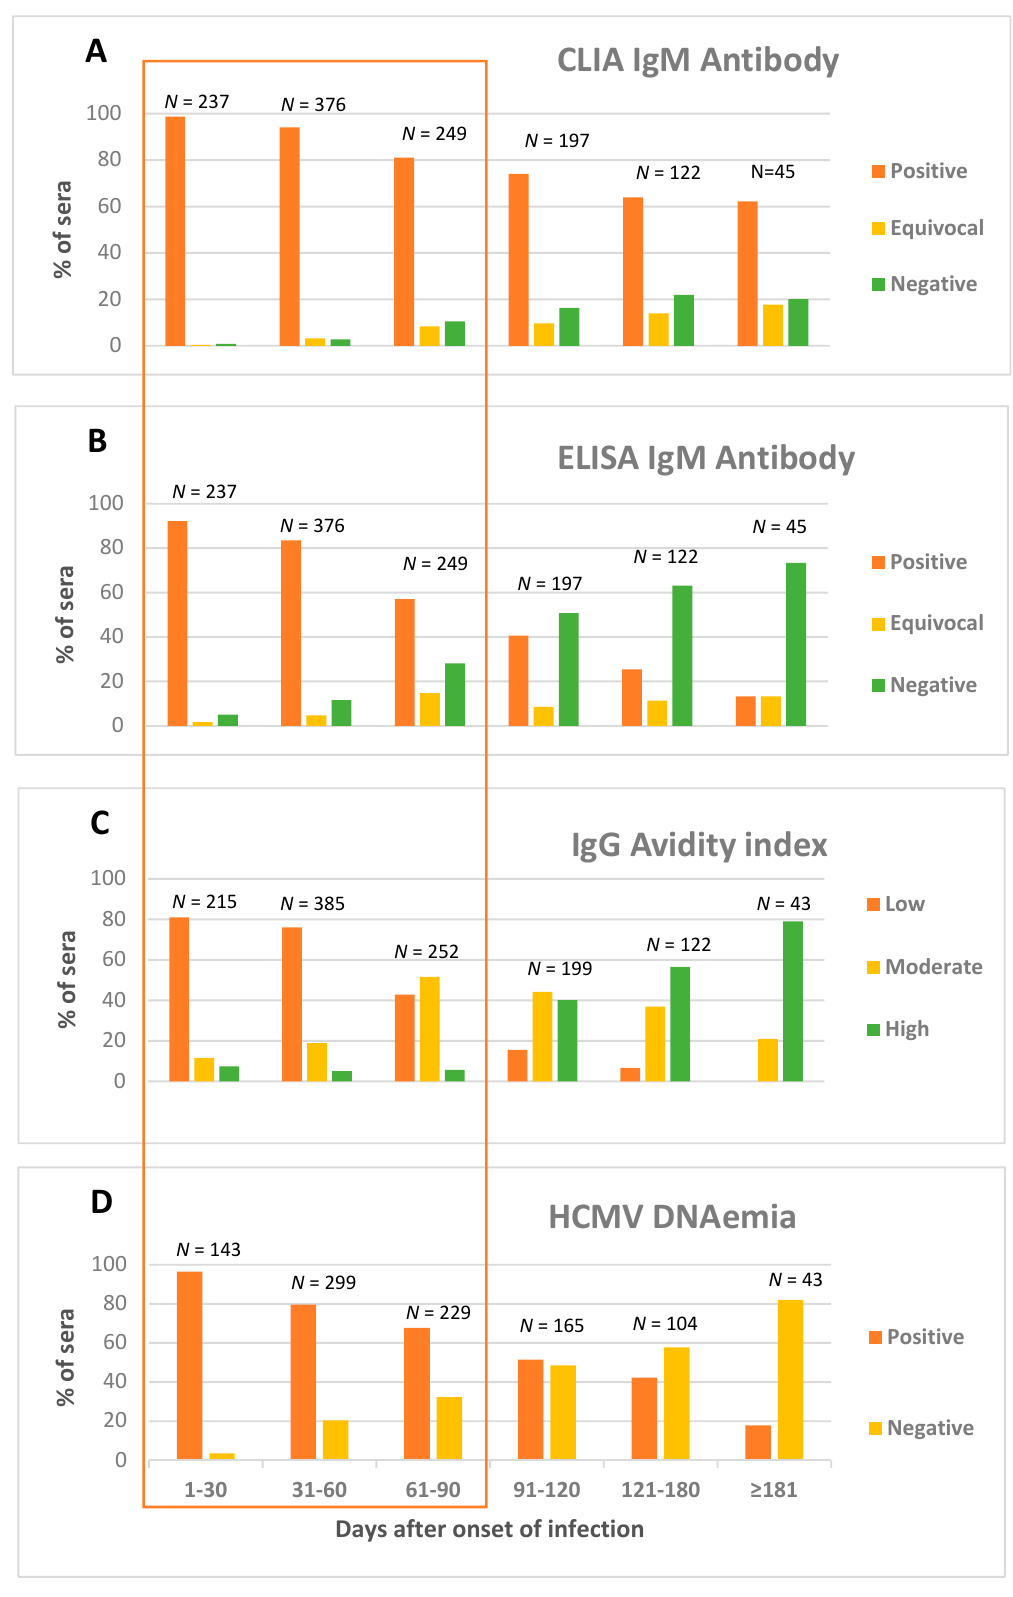
Figure 1. Human cytomegalovirus (HCMV) chemiluminescent immunoassay (CLIA) IgM ( A ) and enzyme-linked im- munosorbent assay (ELISA) IgM ( B ) antibody, IgG avidity index ( C ), and DNAemia ( D ) results, as obtained on sequential serum and whole blood samples from 465 pregnant women with well-defined primary HCMV infection.